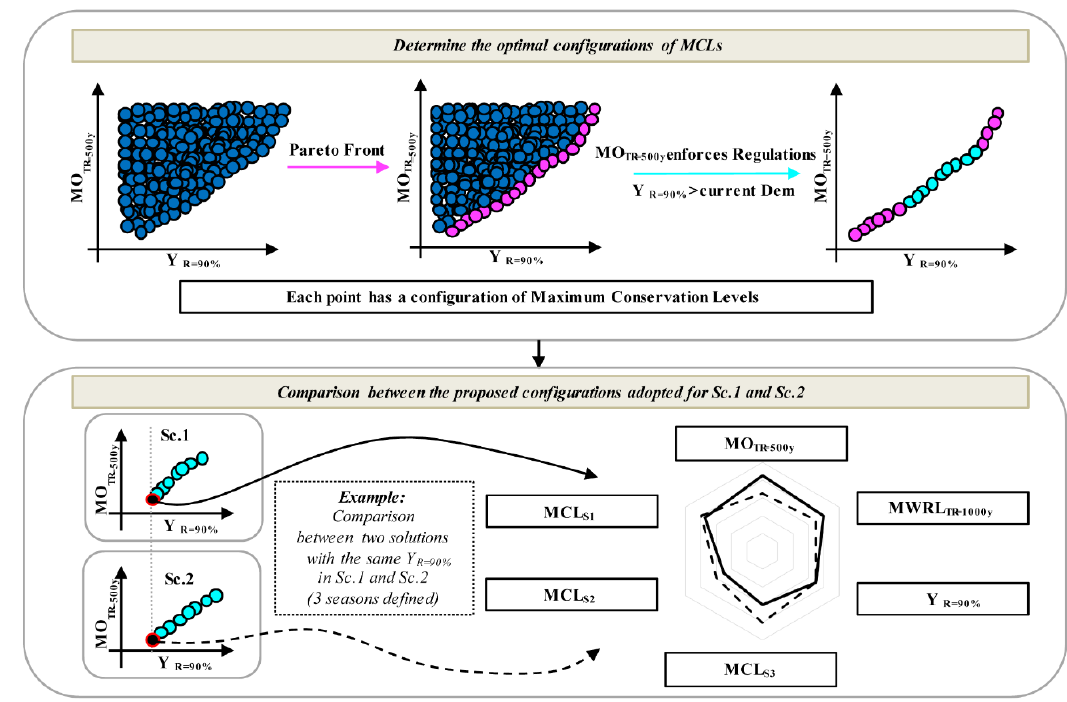
Figure 4. Scheme of the procedure for solutions proposal.